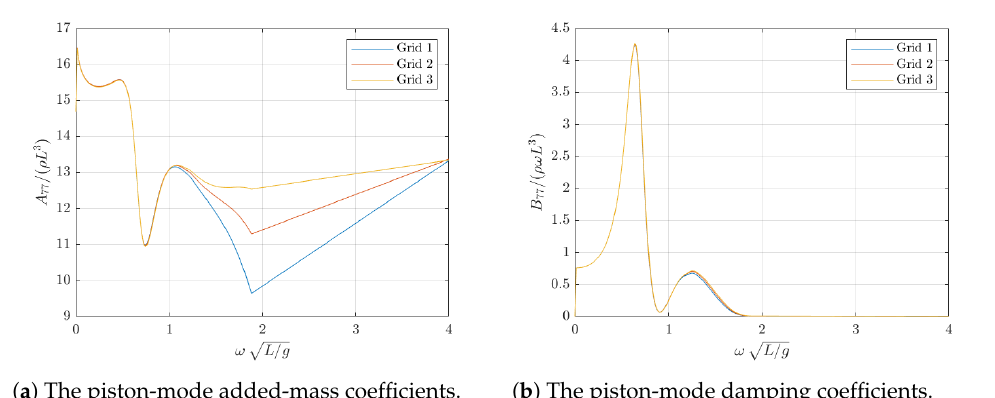
Figure 14. Convergence of the WAMIT piston-mode added-mass and damping coefficients for three grid